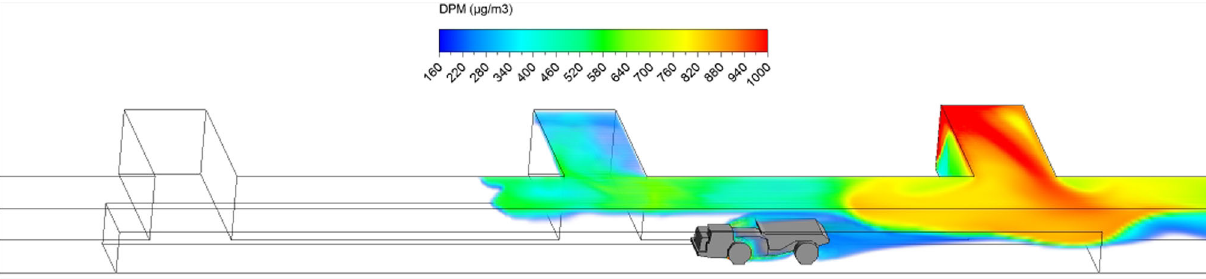
Fig. 10 DPM distributions in scenario 1 during the hauling operation at 195 s